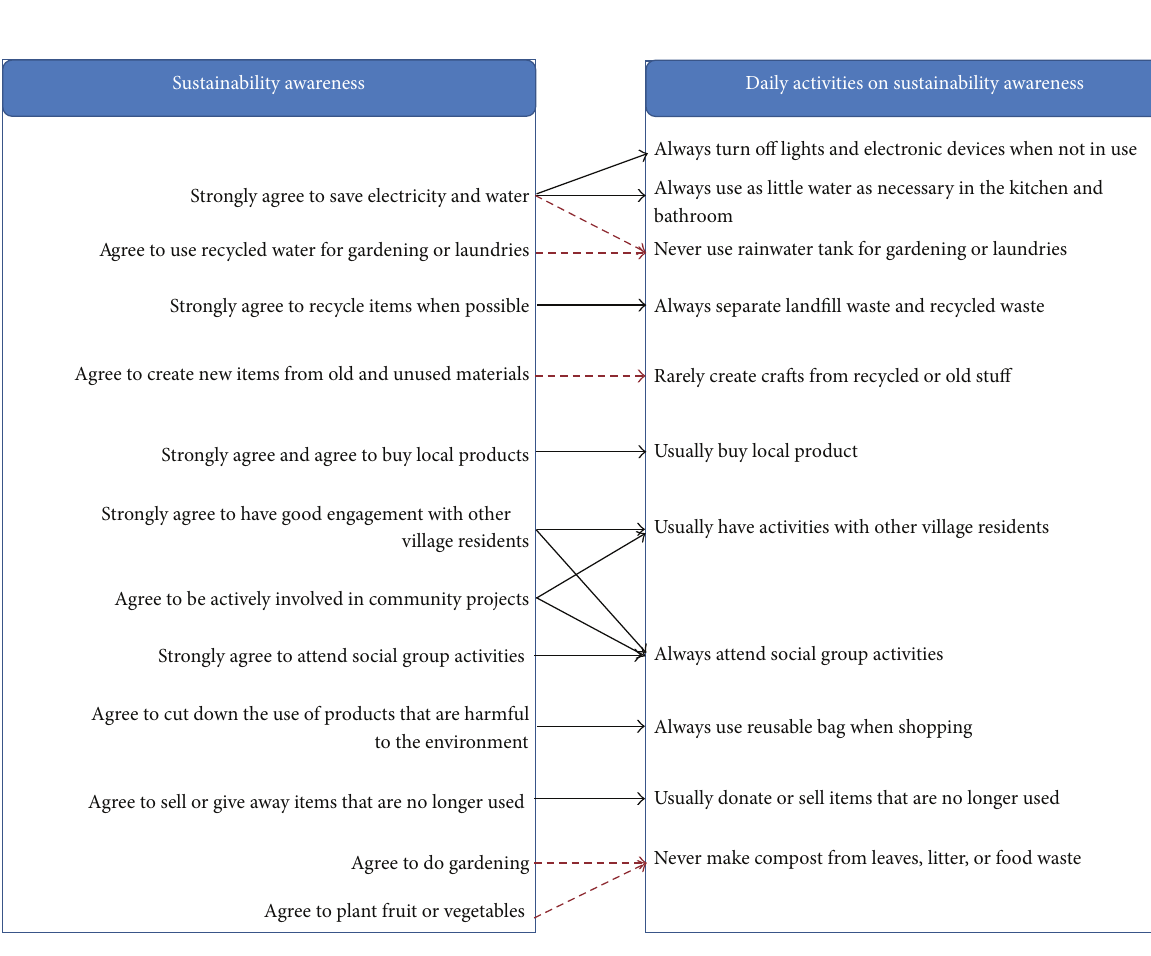
Figure 2: Relationship of sustainability awareness and daily